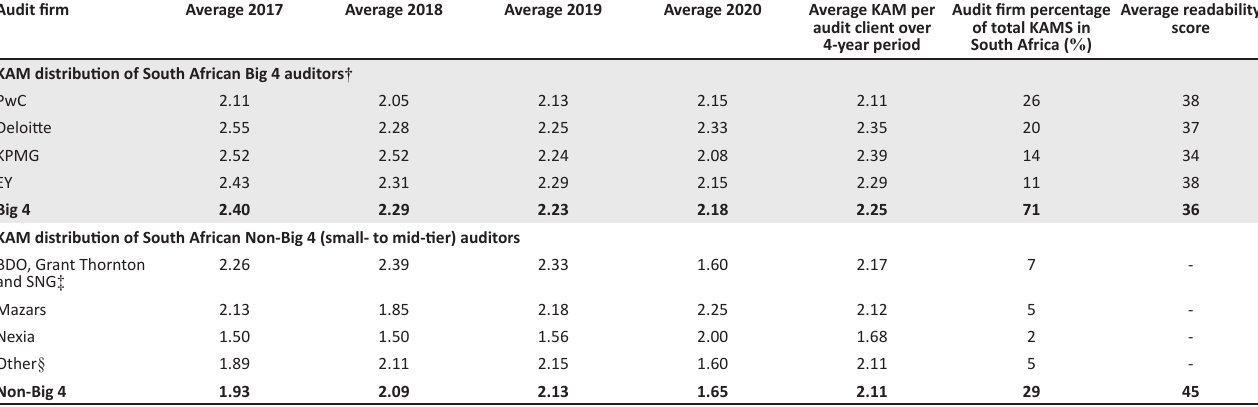
TABLE 3: Average number of key audit matters identified per South African auditors (2017–2020). Audit